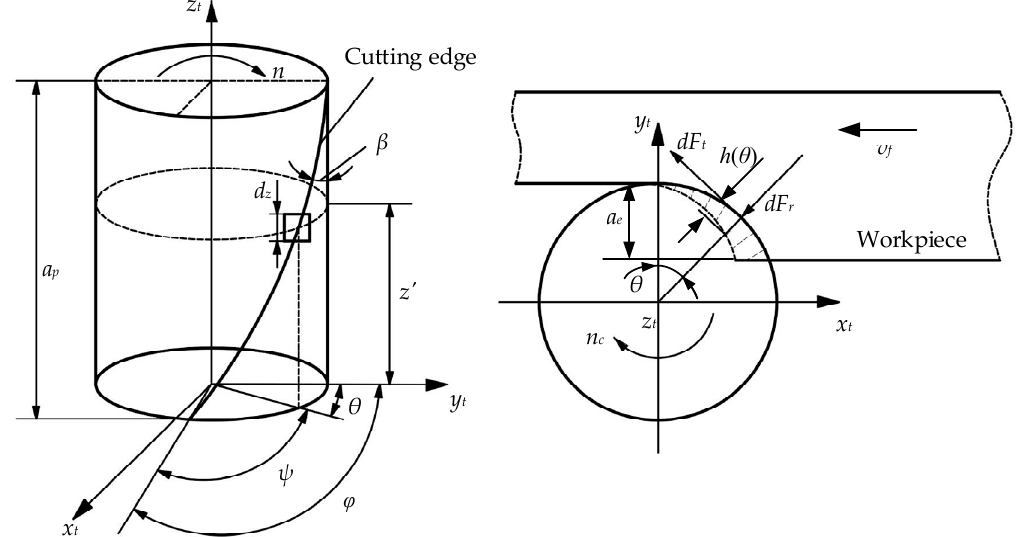
Figure 3. The instantaneous milling force modeling.